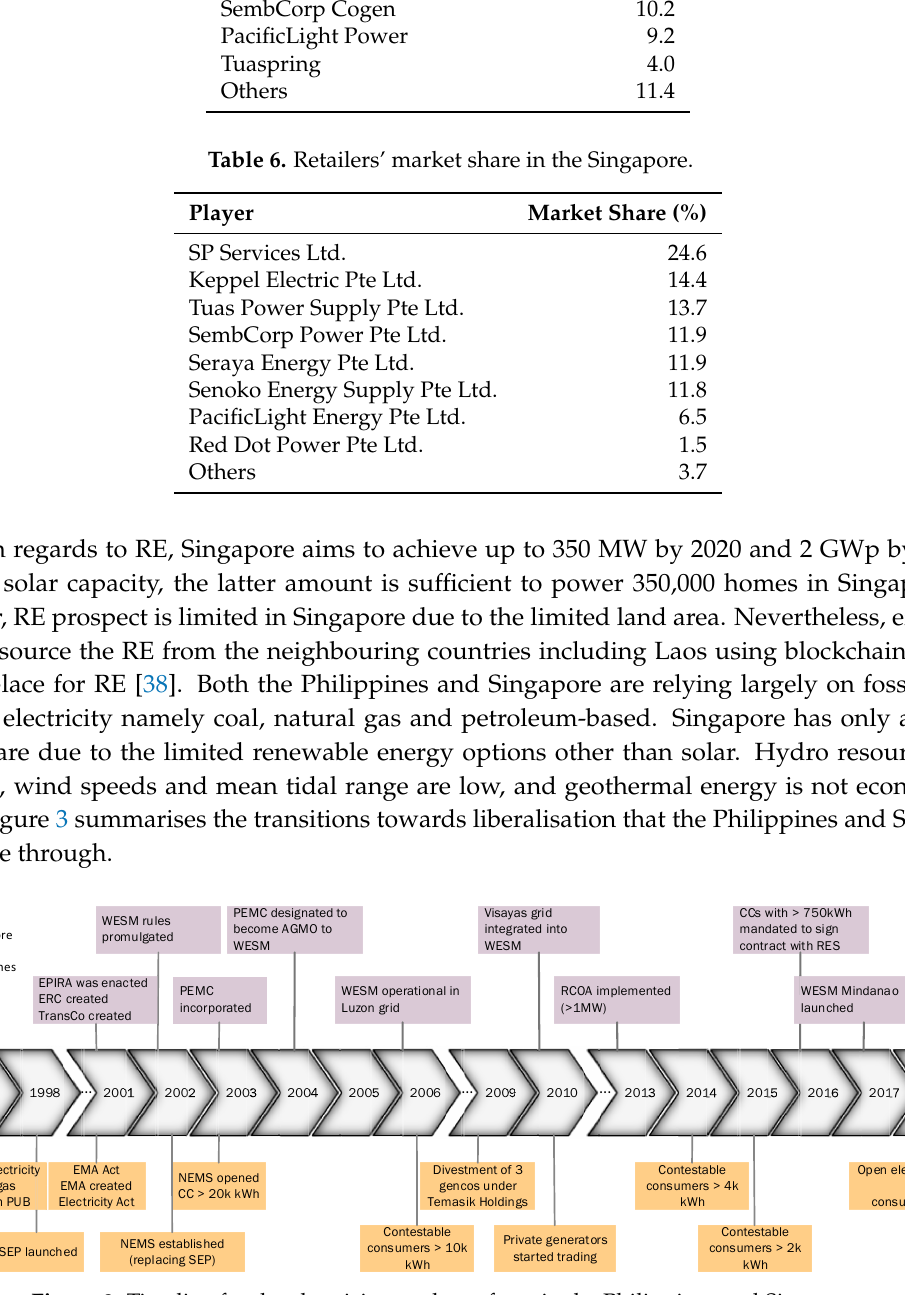
Figure 3. Timeline for the electricity market reform in the Philippines and